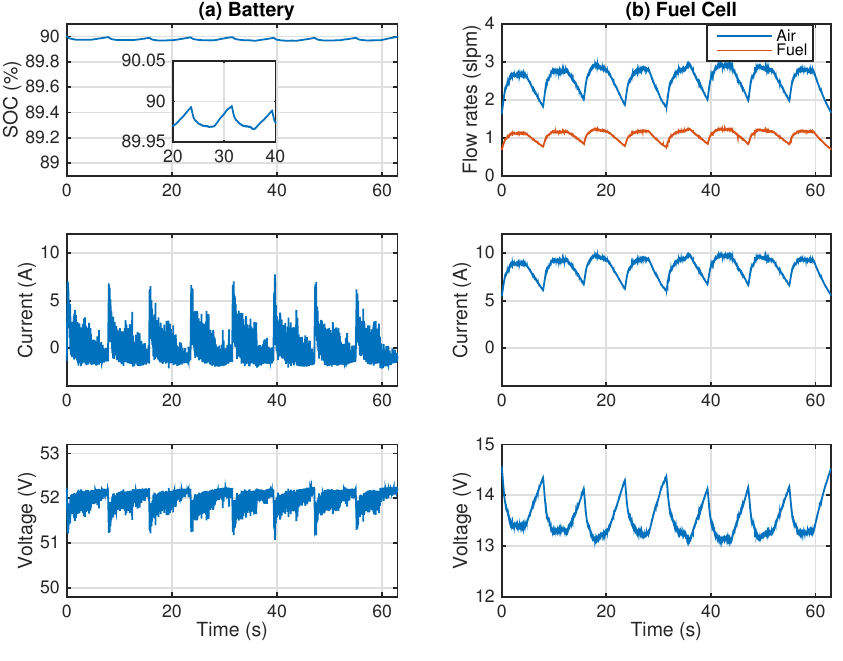
Figure 20. High-SOC semi-active hybrid simulation. ( a ) Battery response and ( b ) FC response. Figure 21 shows the results for the medium-SOC for the semi-active hybrid configura- tion. It shows similar profiles than the ones seen in the high-SOC case but with slightly lower battery voltage due to the reduced SOC. On the other hand, the FC performance is practically equal to the one obtained in the high-SOC